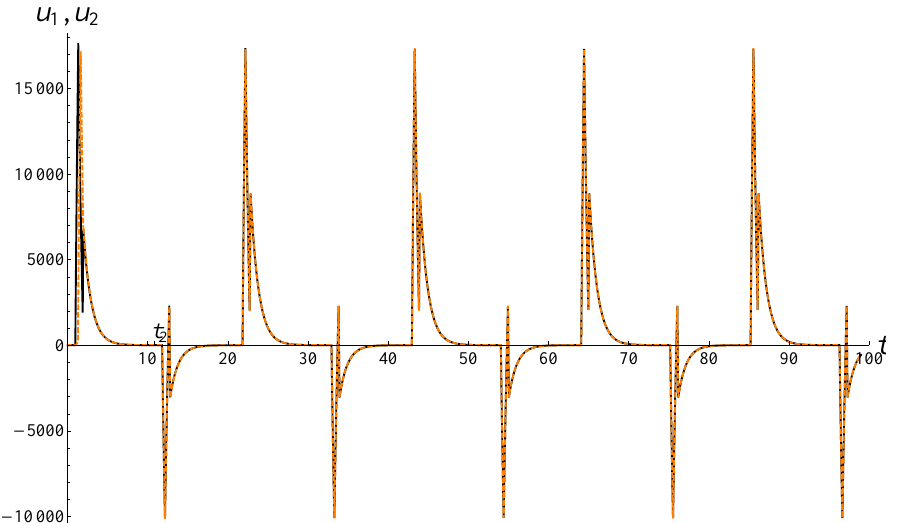
Figure 1. Example of solution. Values of parameters: T = 1, γ = 0.1, p = 1, λ = 10,000. Black line— u 1 ( t ) , orange dashed line— u 2 ( t )